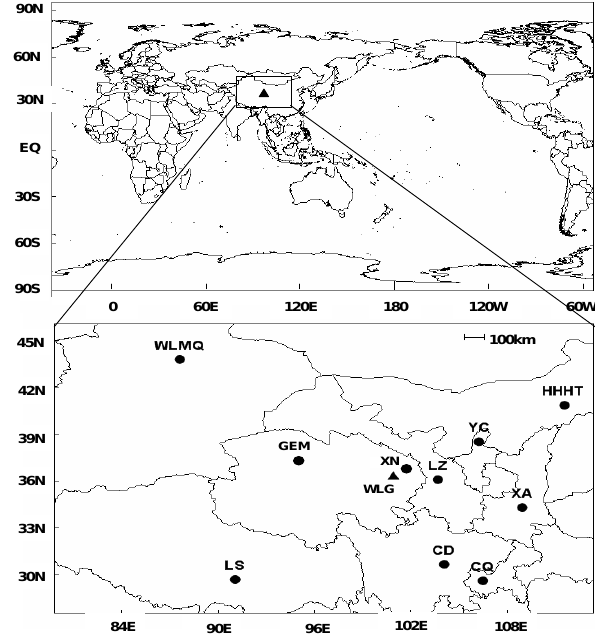
Fig. 1. Map of Waliguan (black triangle) and location of main cities (black dots): CD-Chengdu; CQ-Chongqing; GEM- Ge’ermu; HHHT-Huhehaote; LS-Lasa; LZ-Lanzhou; WLG- Waliguan; WLMQ-Wulumuqi; XA-Xi’an; XN-Xining; YC-